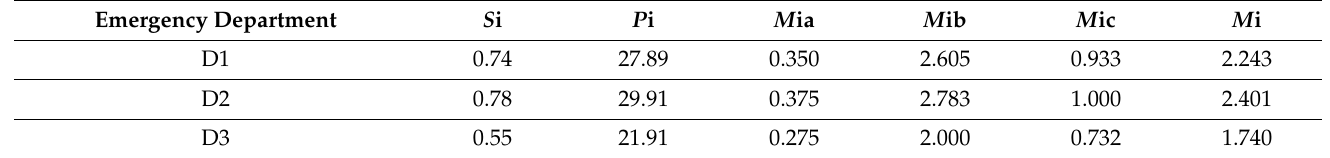
Table 14. The sum of weighted comparability S i, power-weighted comparability sequences P i, and aggregated appraisal scores (emergency department performance